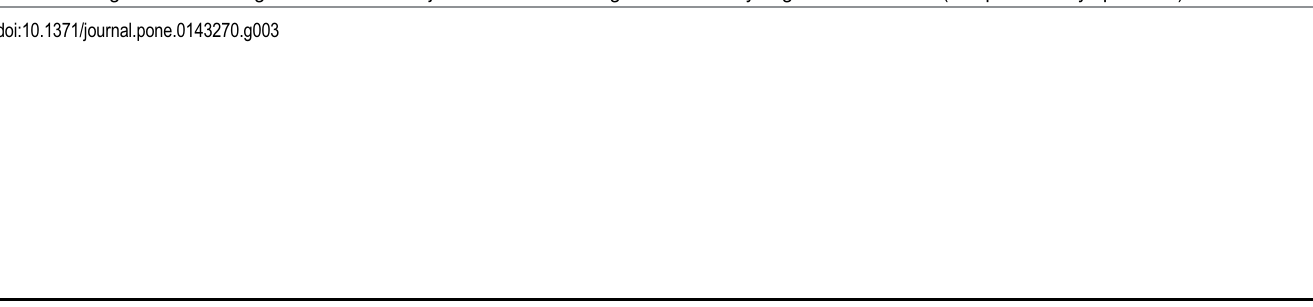
PLOS ONE | DOI:10.1371/journal.pone.0143270 November 13, 2015 3 /